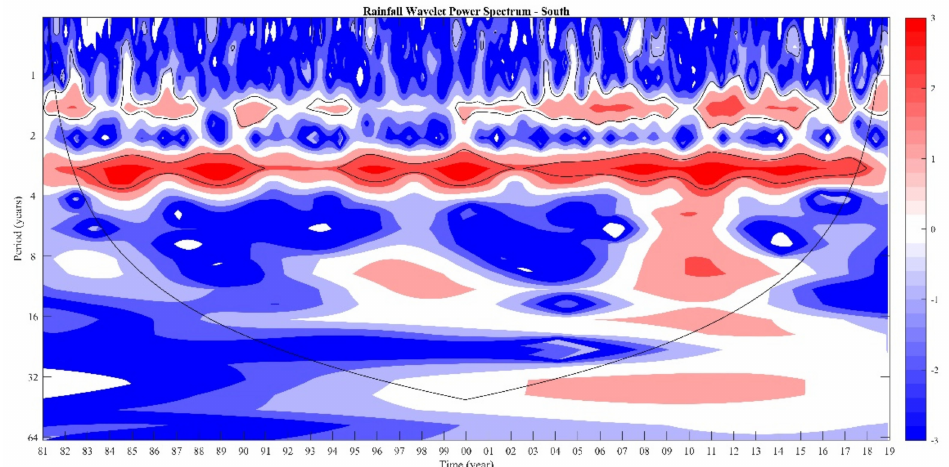
Figure A2. Wavelets (Morlet) analysis south.